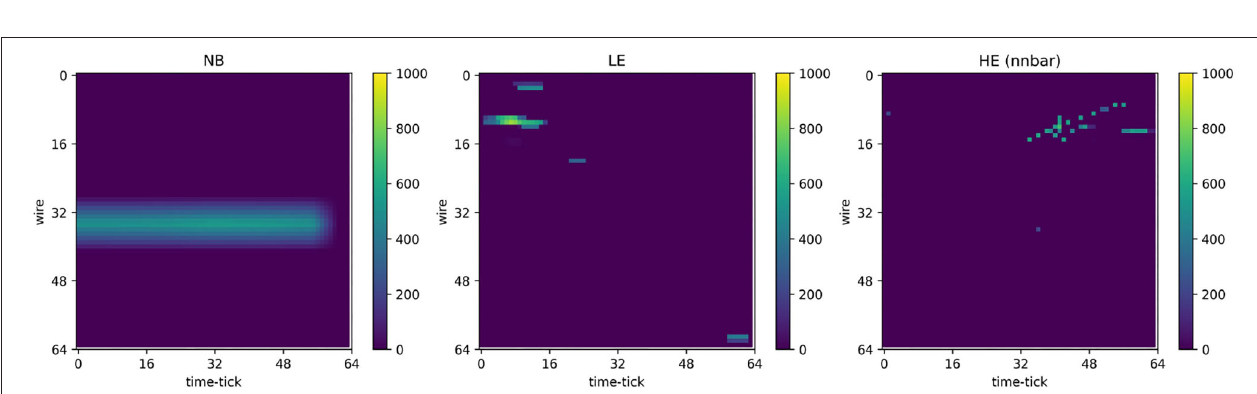
FIGURE 2 | Examples of 2D images formed from one full drift (2.25 ms) of 480 collection plane wires in one DUNE FD cell. Top : Image containing electronics noise and radiological background only (NB). Middle : Image containing one low-energy supernova neutrino interaction (LE) superimposed with electronics noise and radiological background. Bottom : Image containing one high-energy interaction (HE), specifically from neutron-antineutron oscillation (nnbar), superimposed with electronics noise and radiological background. The color z axis indicates the wire waveform ADC value (simulated with 12-bit resolution). These images are pre-processed prior to CNN processing.